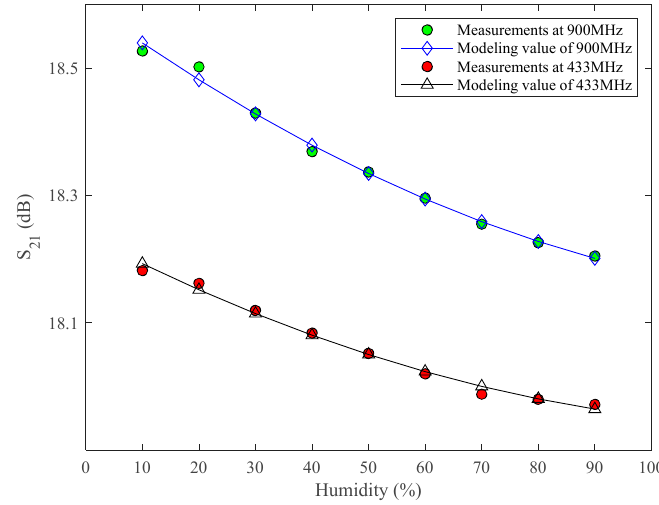
Figure 5. Measured S 21 vs. humidity.